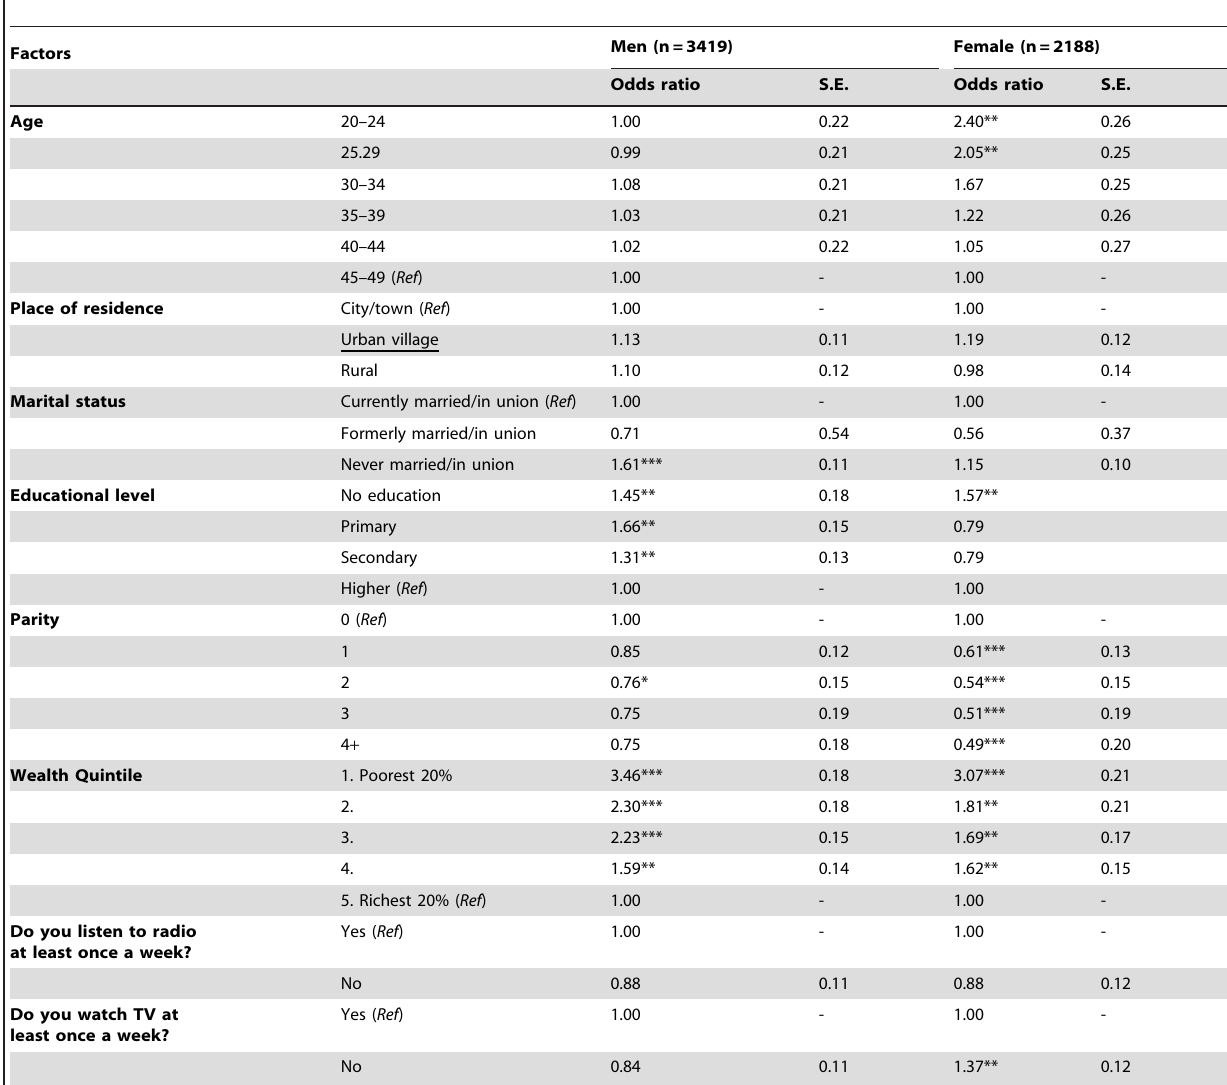
Table 2. Predictors of under-nutrition among adult population aged 20–49 years, Botswana.